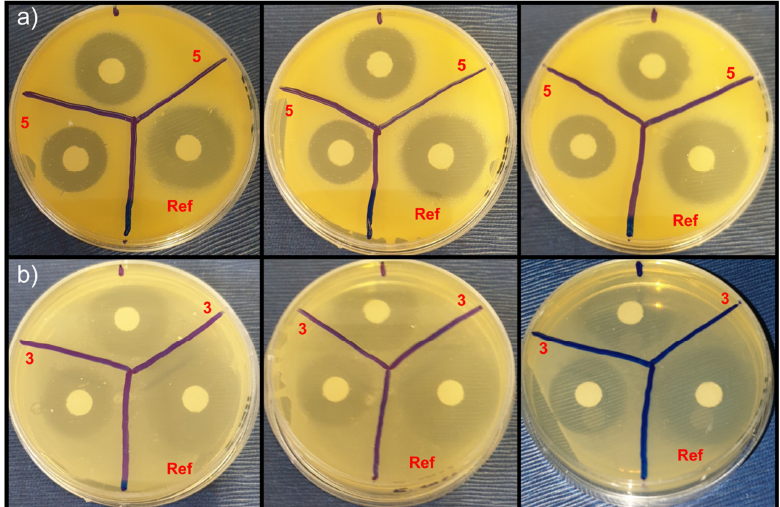
Figure 4. Observed antibacterial effect (experiments were repeated three times) corresponding to 30 µg of compound 5 against S. aureus ( a ) and compound 3 against E. coli ( b ), compared to 30 µg kanamycin (reference). The diameter of the area around the discs, containing the tested compounds, in which no visible growth is observed (zone of inhibition) was measured using ImageJ software [46].